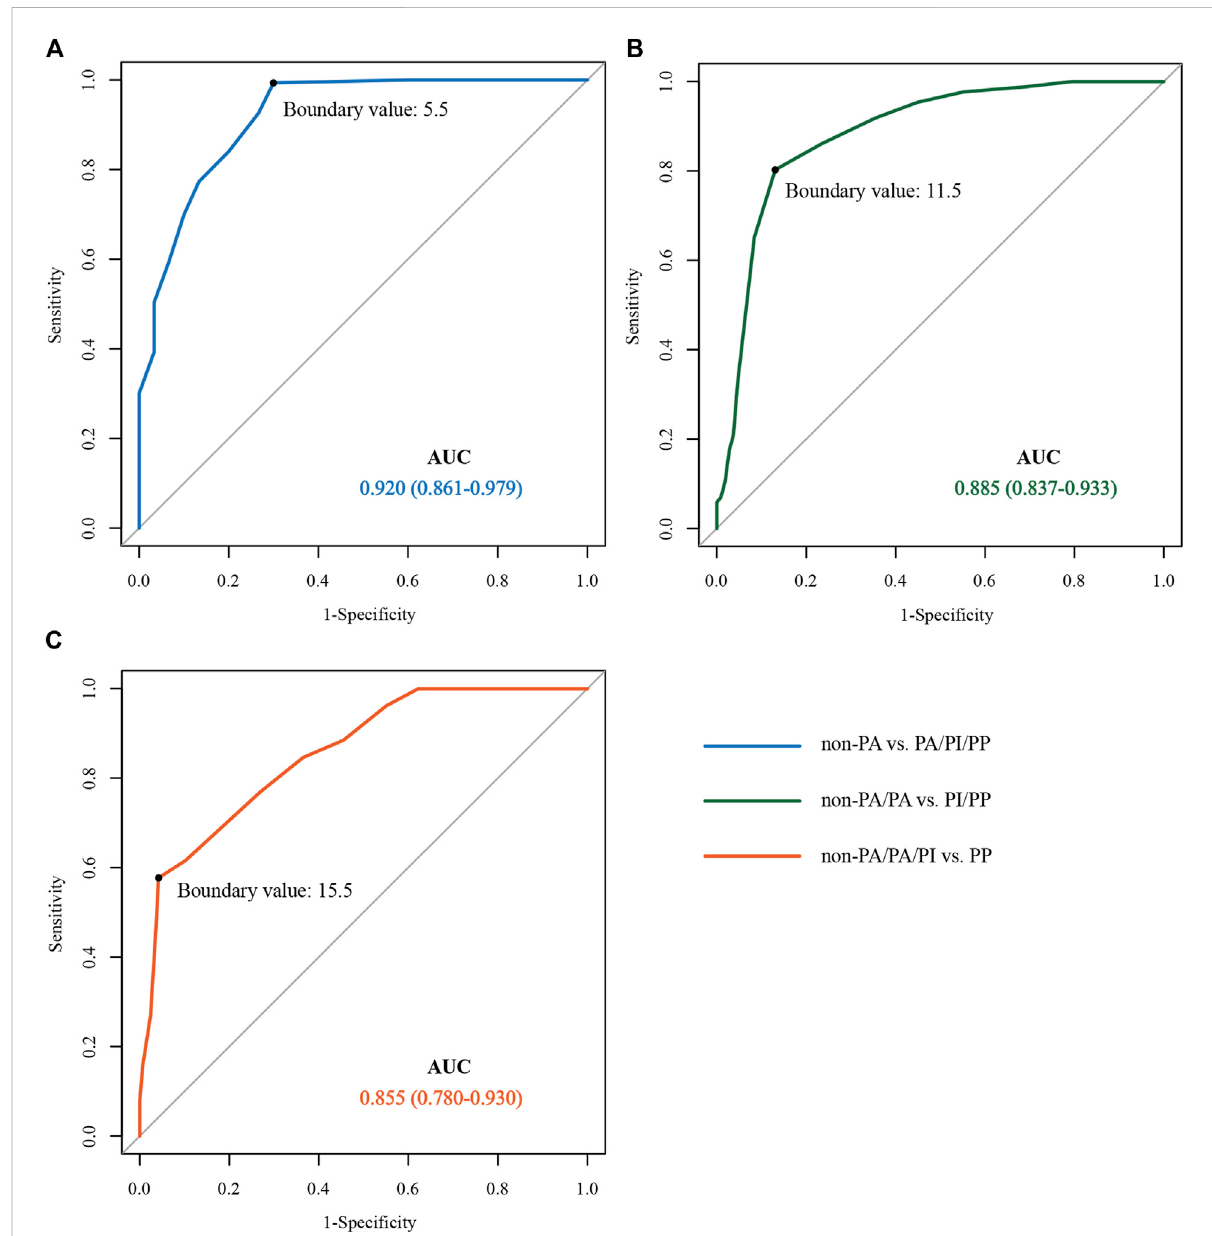
FIGURE 3 ROC curve for predicting different types of pernicious placenta previa based on the MRI scoring system. (A) non-PA vs. PA/PI/PP ROC curves; (B) non-PA/PA vs. PI/PP ROC curves; (C) non-PA/PA/PI vs. PP ROC curves. ROC, receiver operating characteristic; MRI, magnetic resonance imaging; PA, placental adhesion; PI, placental implantation; PP, placenta